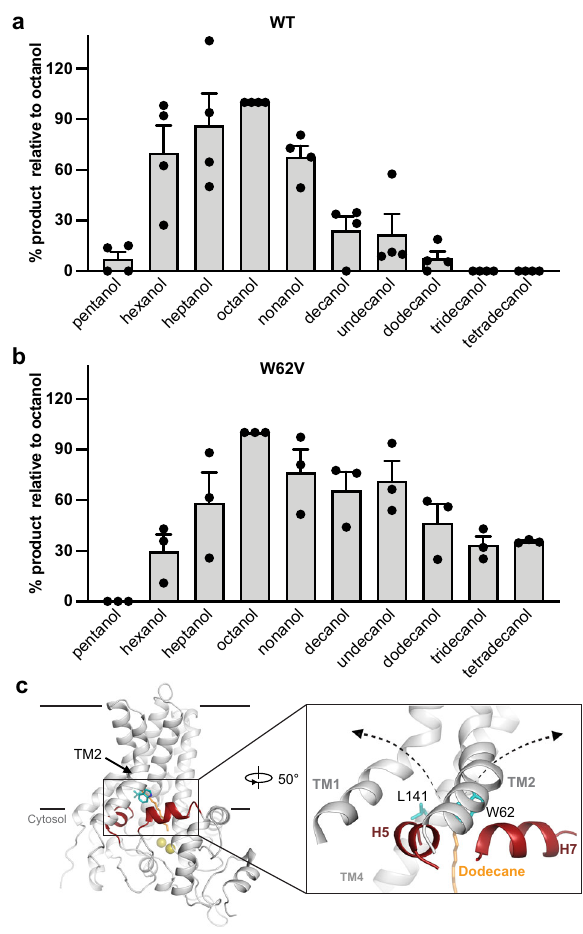
Fig. 4 | W62V shifts the substrate length of FtAlkB. a , b Alkane hydroxylation activities of WT ( a ) and W62V ( b ) on straight alkanes ranging from 5 to 14 carbons (mean±SEM; n =4 independent experiments for WT, n =3 independent experi- ments for W62V). Source data are providedasa SourceData fi le. c Potential lateral pathwaysforsubstrateentryorproductrelease.Dodecaneisshowninorange.Key residues are shown in cyan sticks and selected short helices are shown in